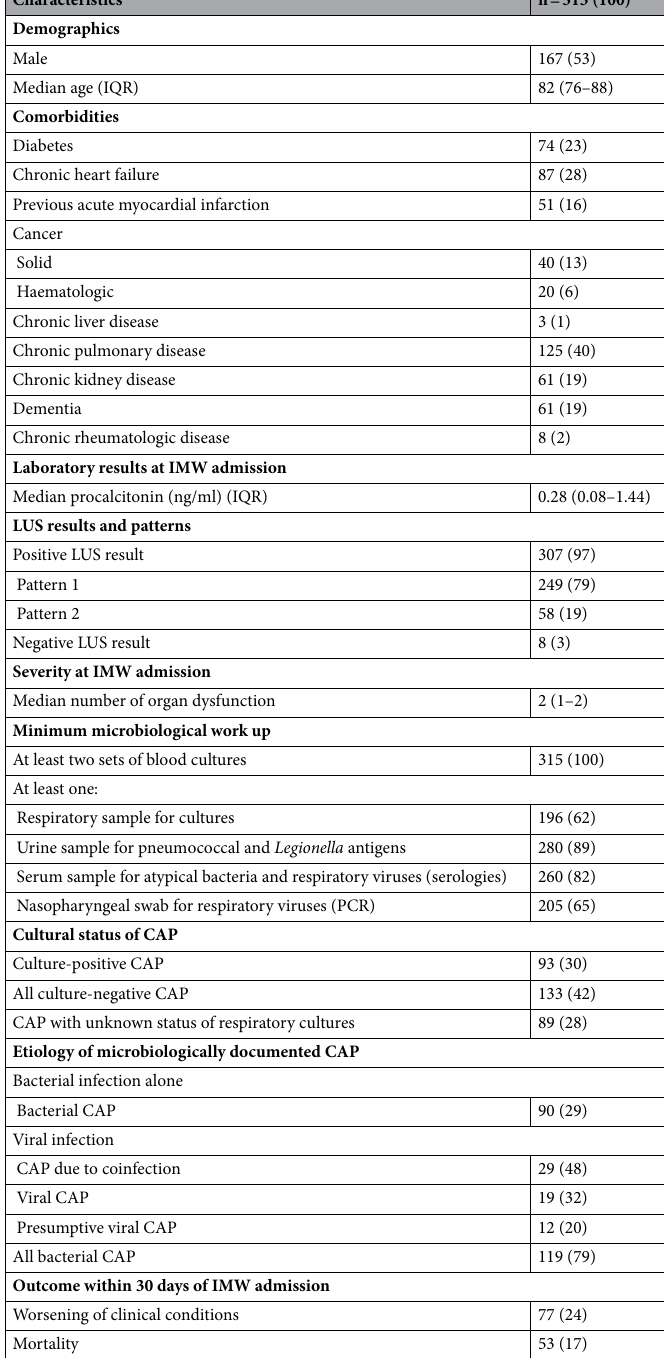
Table 1. Patients with definitive diagnosis of community-acquired pneumonia: characteristics at internal medicine ward admission, lung ultrasound results and positive patterns, extension of the minimum microbiological work up, main microbiological cohorts, and outcome at 30 days. IQR interquartile range, IMW internal medicine ward, LUS lung ultrasound, PCR polymerase chain reaction, CAP community-acquired pneumonia. Please see Supplement for discursive definitions of each microbiological cohort of community- acquired pneumonia